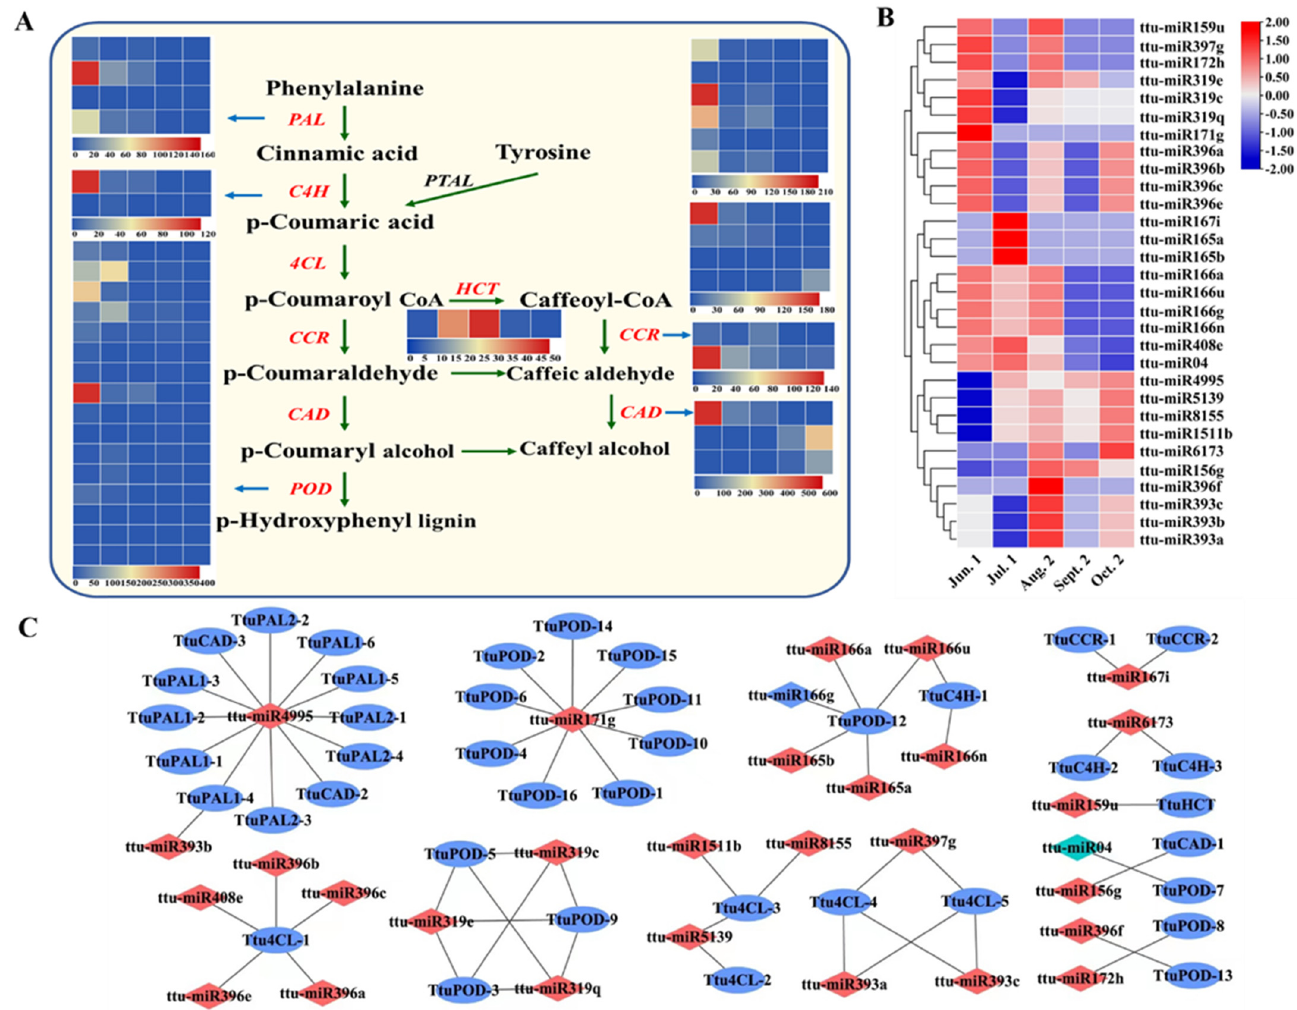
Figure 7. Enrichment analysis of candidate targets in lignin biosynthesis pathway. ( A ) Represents miRNA targets functions involved in lignin biosynthesis. Heat maps of gene expression levels (FPKM) at five different seed maturation stages. ( B ) Heat map of expressed miRNAs involved in lignin biosynthesis pathway. ( C ) Represents the view of miRNA-mRNA network involved in lignin biosynthesis. The red color represents miRNA and the blue color represents targets.